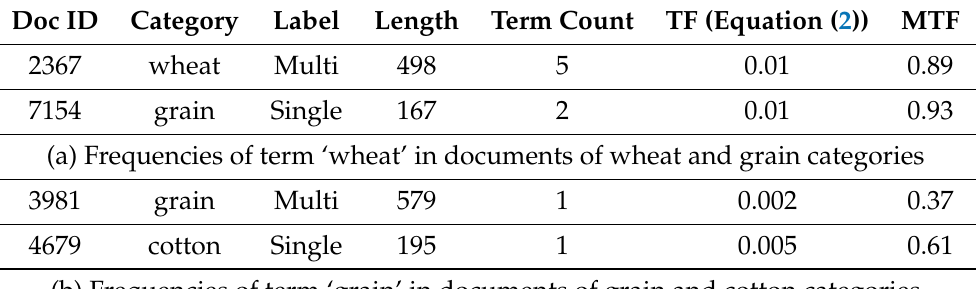
Table 2. Normalized Term Frequency for two documents of the Reuters